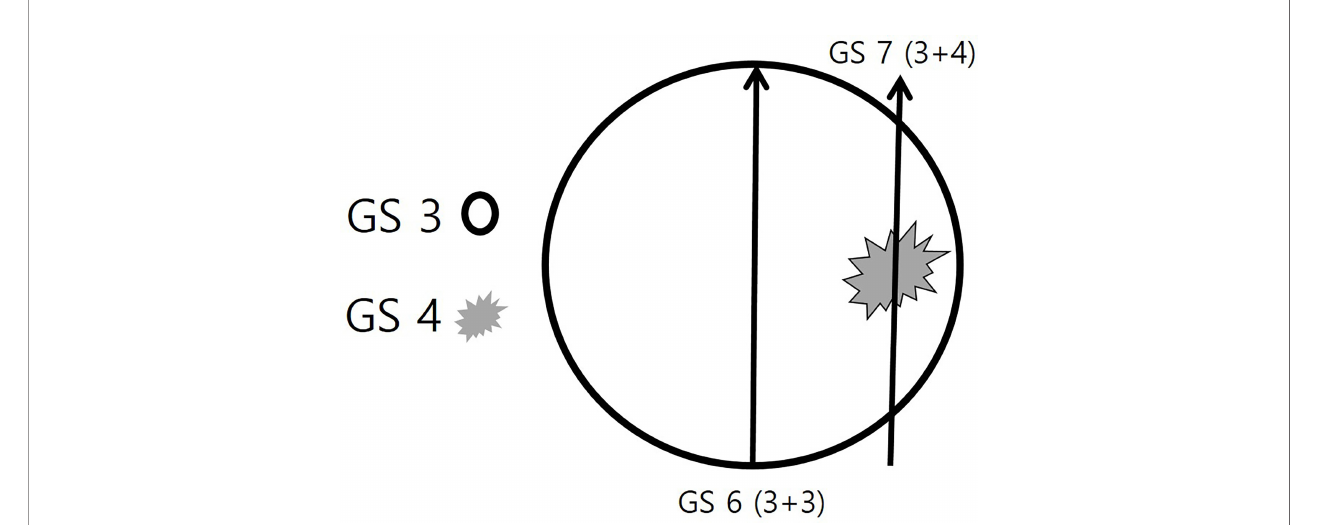
FIGURE 2 | Schematic illustration of the target biopsy strategy. A round prostate cancer consists of two Gleason score (GS) components of GS 3 and GS 4. The GS 3 (black circle) is the major component and the GS 4 (gray spiculation) is the minor component. If a radiologist or urologist targets the central area alone, the histologic diagnosis will be a GS 6 (3 + 3) adenocarcinoma. However, if the periphral area is targeted, the histologic diagnosis will be a GS 7 (3 + 4)